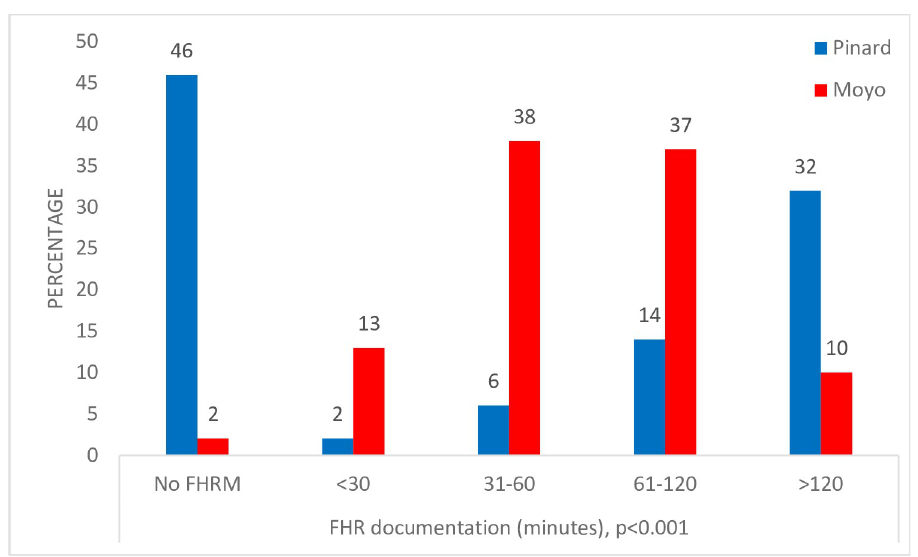
Fig 3. Frequency of Fetal Heart Rate monitoring and documentation post-implementation vs pre- implementation of the Moyo.